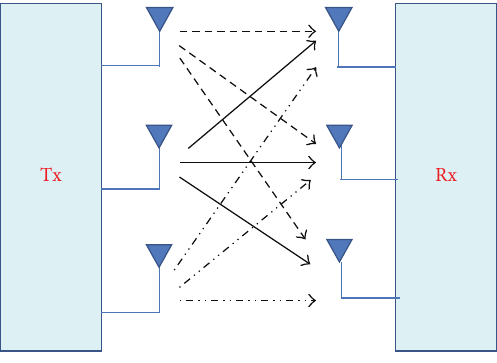
Figure 3: Basic structure of MIMO